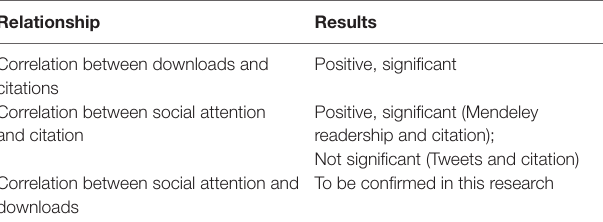
Table 2 | Research gap and our research questions.